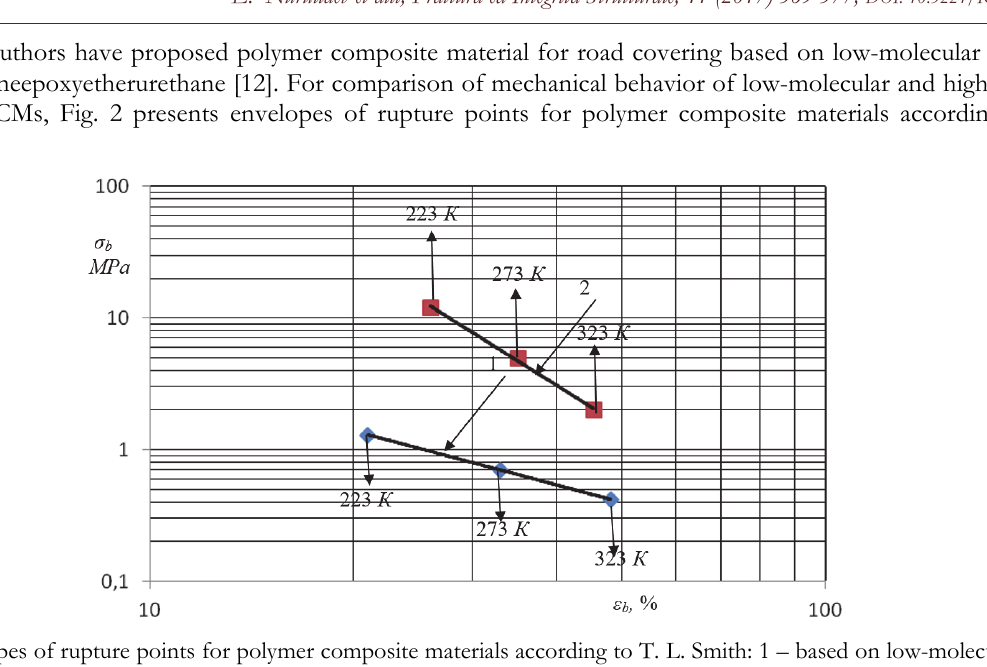
Table 4: Numerical experimentation results by determination of maximum mechanical fracture energies for PCM.